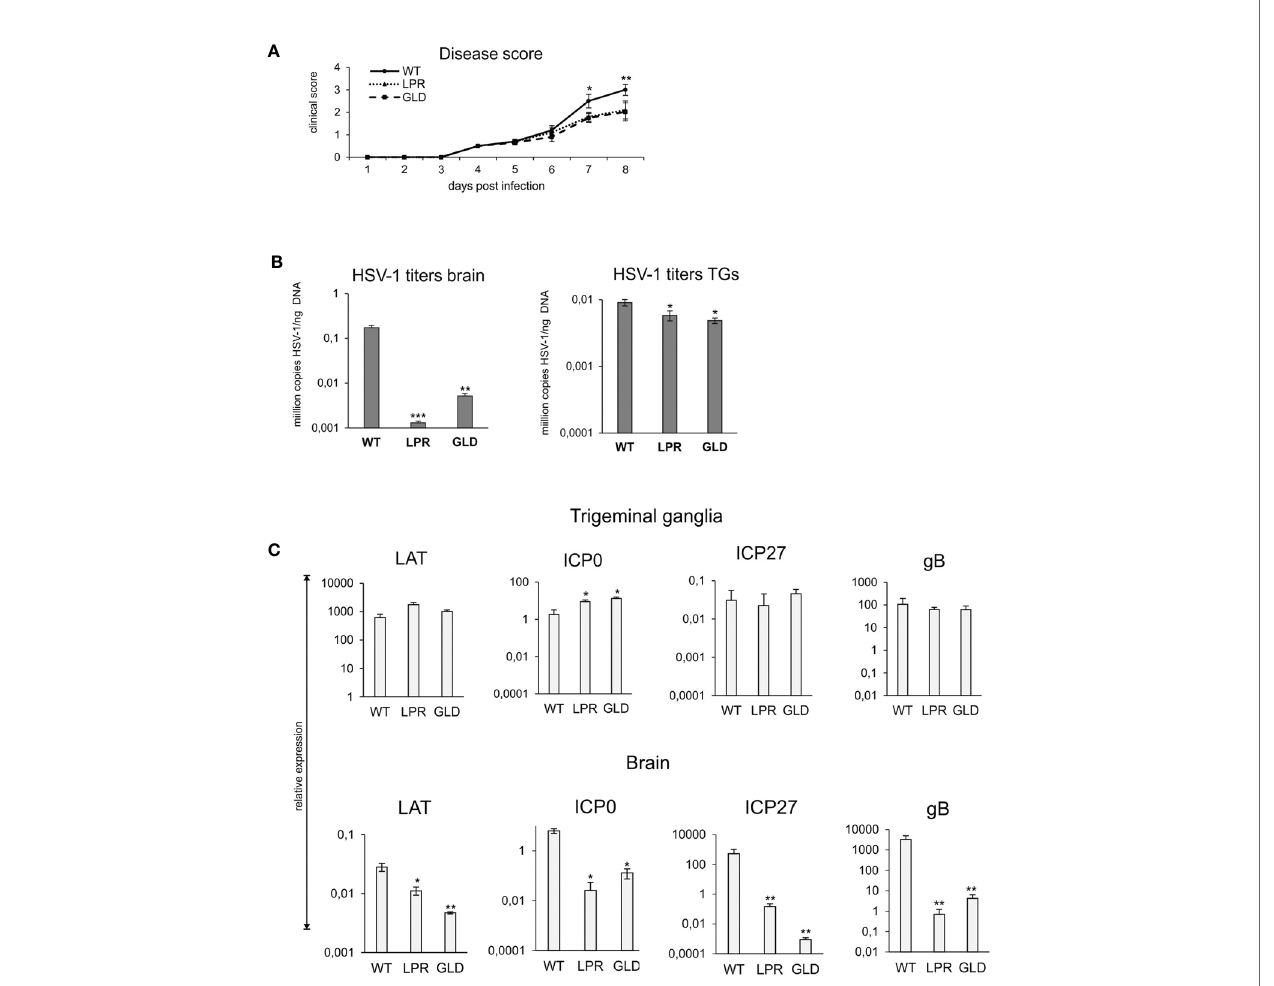
FIGURE 2 | Lack of Fas/FasL decreases morbidity in HSV-1 encephalitis. (A) C57BL/6 (WT), B6. MRL-Fas lpr/J (Fas − ) and B6Smn.C3-Fasl gld/J (FasL − ) mice were infected intranasally and monitored for encephalitis symptoms on a daily basis. (B) Viral loads were quanti fi ed using qPCR detecting gB gene in DNA extracted from brains and trigeminal ganglia. (C) Expression of HSV-1 mRNA for ICP0, ICP27, gB and LAT was measured by qPCR and normalized to beta-actin. Upper panel – trigeminal ganglia, lower panel – brain. All data were presented as mean ± SEM, N = 10. Data analysis was performed by comparing Fas-de fi cient (lpr) and FasL- de fi cient (gld) groups with wild-type (C57BL/6) mice. ***indicates P ≤ 0.001, while **P ≤ 0.01 and *P ≤